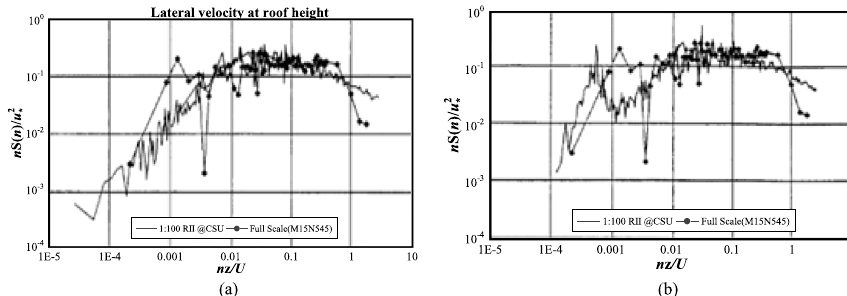
Fig. 4 Influence of the grid motion state to the vertical wind spectra function (Lin and Wan, 1972). a Static grid, b Vibrating grid